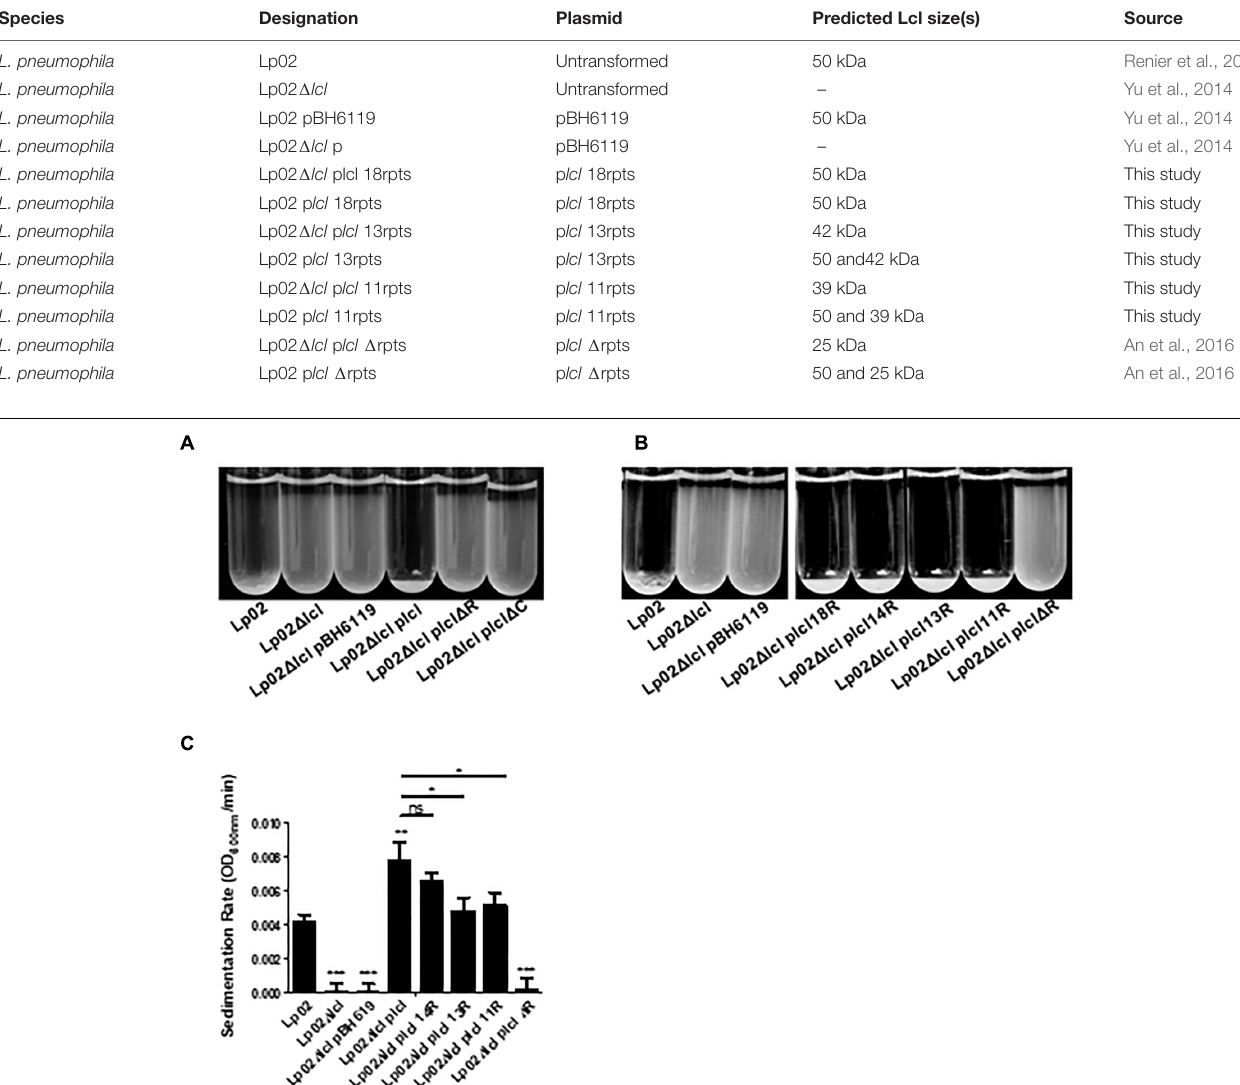
FIGURE 6 | Both the R domain and the C terminal domain are required for L. pneumophila cell–cell binding. (A,B) Sedimentation assays of L. pneumophila in deionized water with 10% BYE after overnight incubation with Lp02 (cid:49) lcl transformed with p lcl (cid:49) R and p lcl (cid:49) C (A) and p lcl containing 18, 14, 13, 11 or (cid:49) collagenous repeats (B) . (C) Sedimentation rates of Lp02 (cid:49) lcl transformed with p lcl containing the indicated numbers of collagenous repeats. Rates were calculated by calculating the rate of OD 600 nm decrease after the first 100 min. ∗ , ∗∗ , and ∗∗∗ denotes p < 0.05, 0.01, and 0.001, respectively, using one-way ANOVA between the indicated strains. Where no direct comparison is made symbols denote differences with Lp02. Experiments were performed in triplicate.